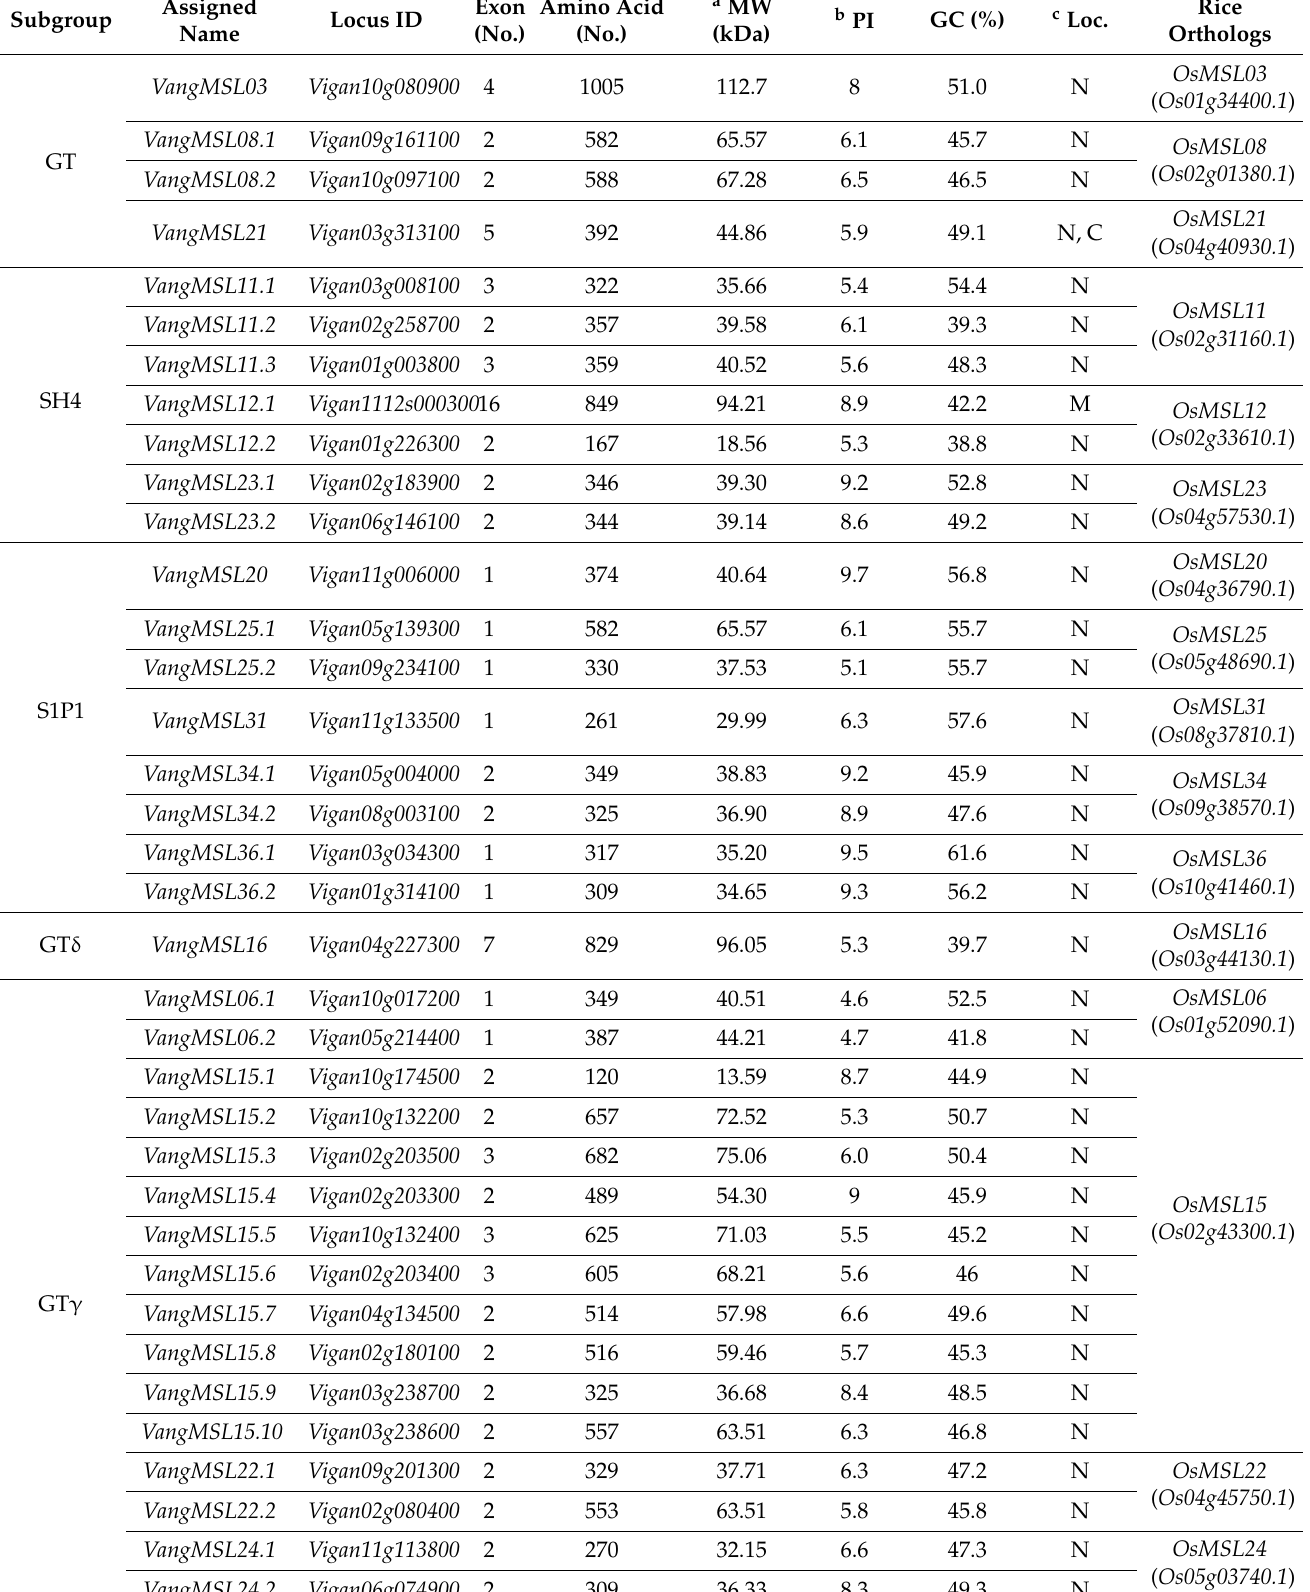
Table 3. Basic Characteristics of Vigna angularis Trihelix